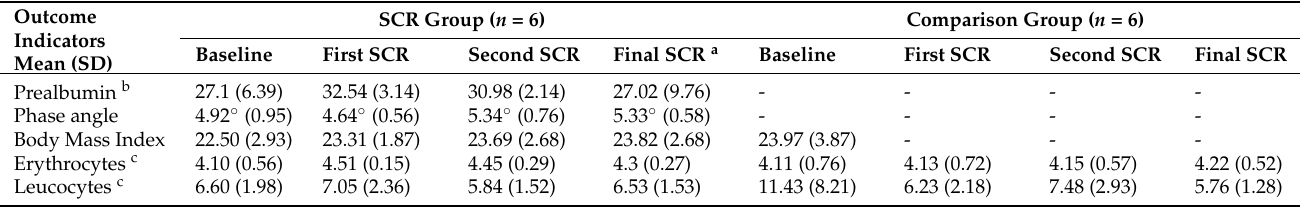
Table 2. Outcomes of short-term calorie reduction (SCR) and comparison groups before and after intervention.